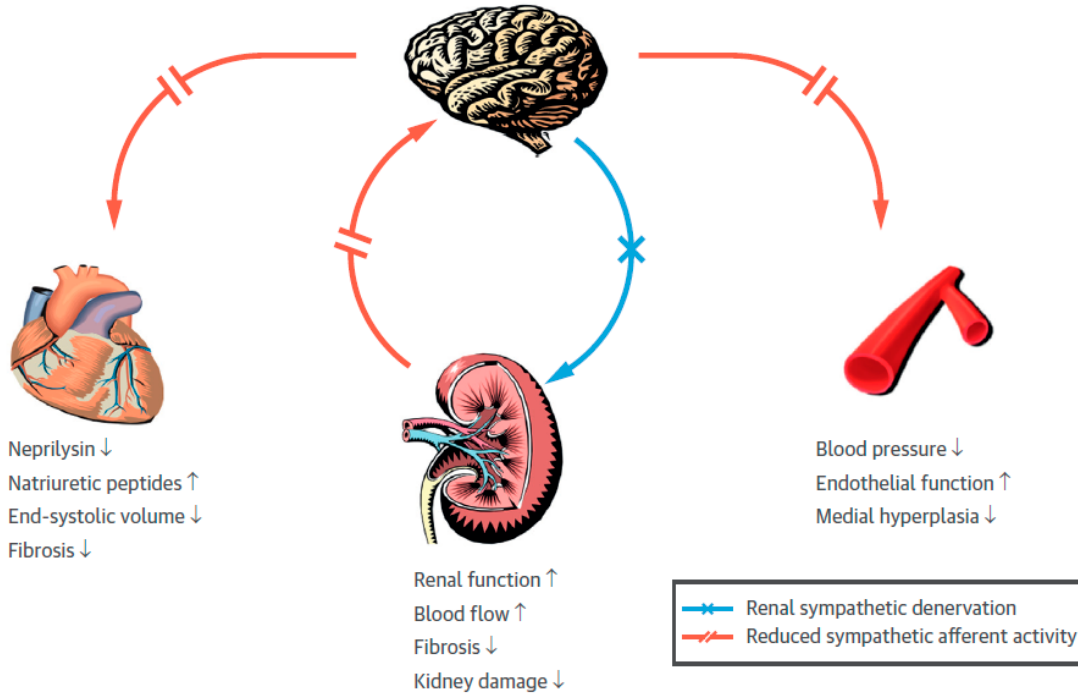
Figure 7. E ff ects of renal sympathetic denervation. Sympathetic e ff erent activation is generated in the central nervous system. E ff erent sympathetic nerves (red lines) target the heart, kidney, and vessels and produce neprilysin activation (new finding), inotropic e ff ects, but also fibrosis, beta adrenergic down-regulation and contractile dysfunction. In the kidney, the vasoconstriction increases renin activation and enhanced sodium water retention, contributing to fibrosis and kidney damage. Peripheral arterial afterload increases by vasoconstriction and, in the long run, BP is increased. Atherosclerosis is initiated, and media hyperplasia takes place. Interruption of a ff erent as well as e ff erent kidney nerve fibers by using renal sympathetic denervation (red cross) reduces sympathetic outflow (interrupted red lines) and potentially reverses these pathological findings [111]. Down arrows = e ff erent sympathetic activation. Up arrows = a ff erent sympathetic activation.